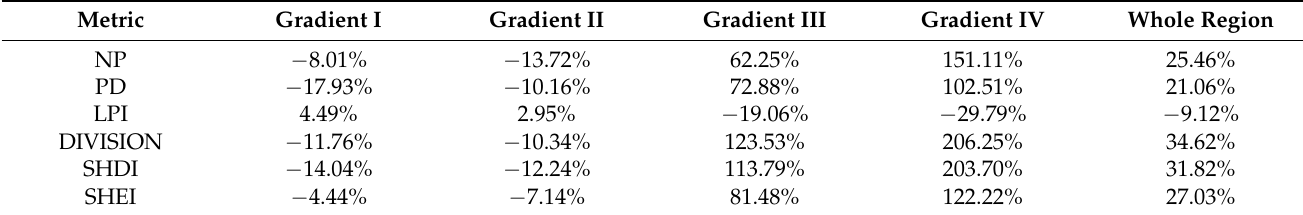
Table 7. Change rate of landscape metrics from 2005 to